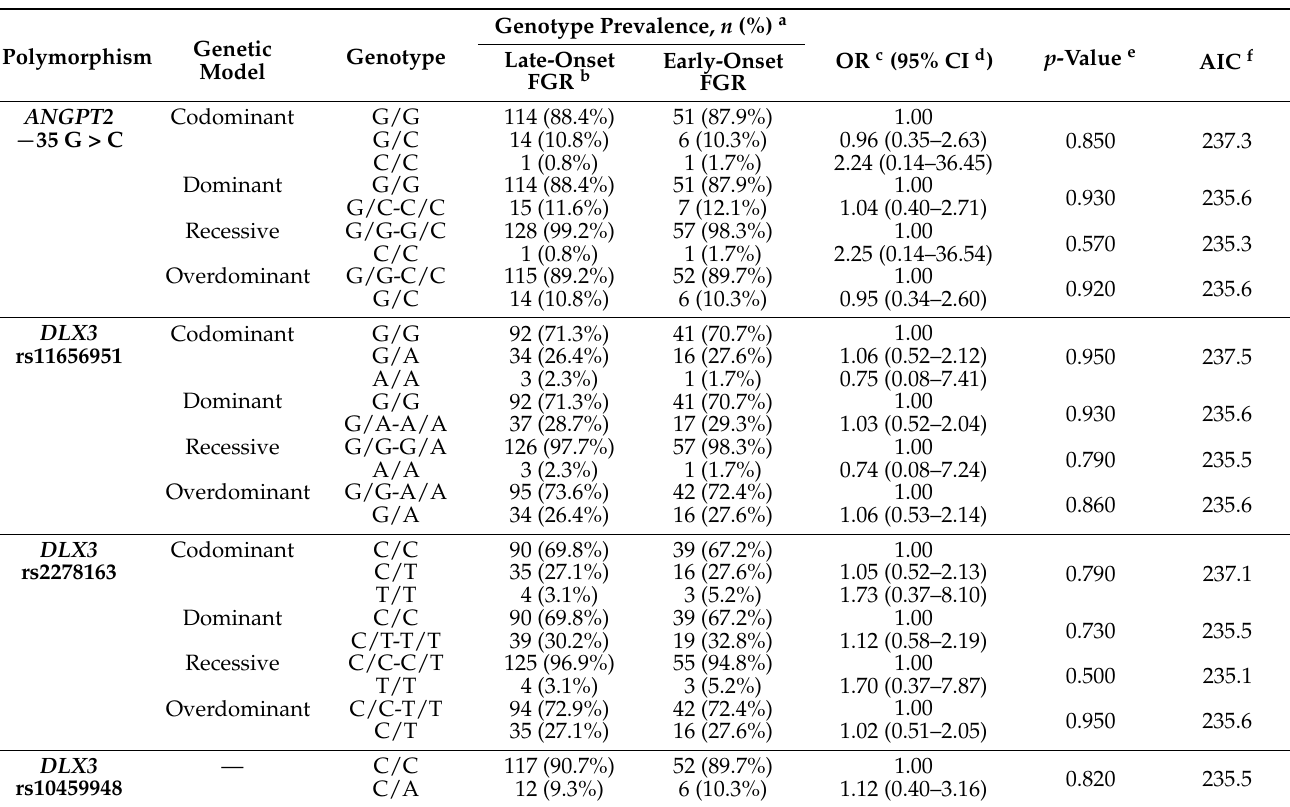
Table 3. Distribution of genotypes from ANGPT2 , DLX3 , HLX , and ITGAV polymorphisms between the women with early and late-onset